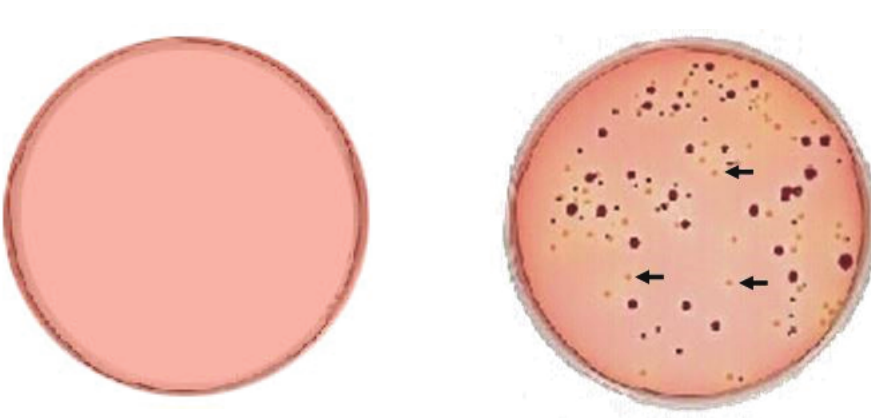
Figure 1 : Identification of Verotoxin-producing E. coli O157:H7 in Sorbiltol MacConkey agar (SMAC)